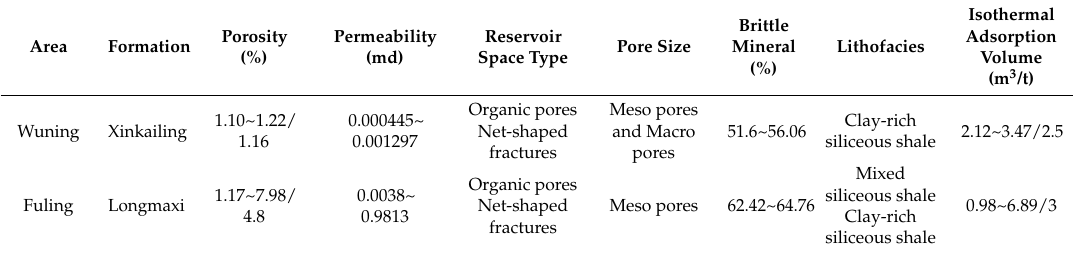
Table 2. Comparison of the reservoir parameters between the Xinkailing-formation shale in Wuning and the Lower Paleozoic-formation shale in the middle-upper Yangtze area.